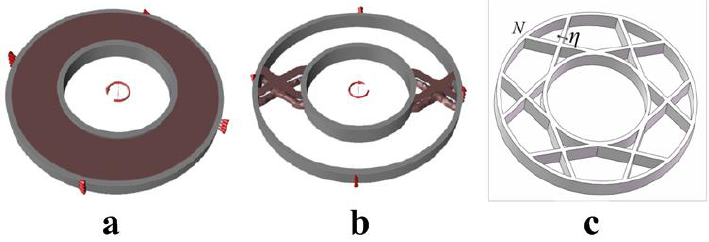
Figure 14. The original ring model ( a ), ring frame obtained by topology optimization ( b ), the final ring frame after optimization ( c